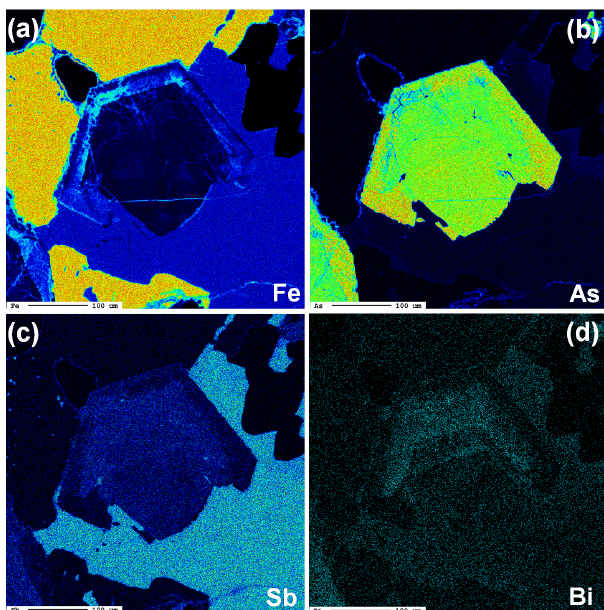
Figure 6. X-ray maps showing the distribution of Fe (a) , As (b) , Sb (c) , and Bi (d) , collected on the same zoned crystal in Fig.